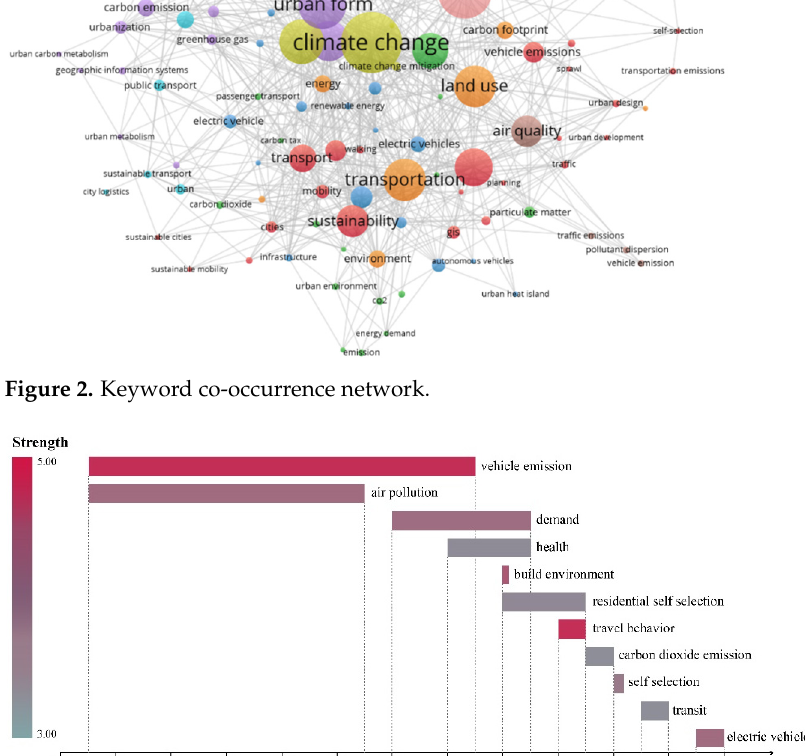
Figure 2. Keyword co-occurrence network.